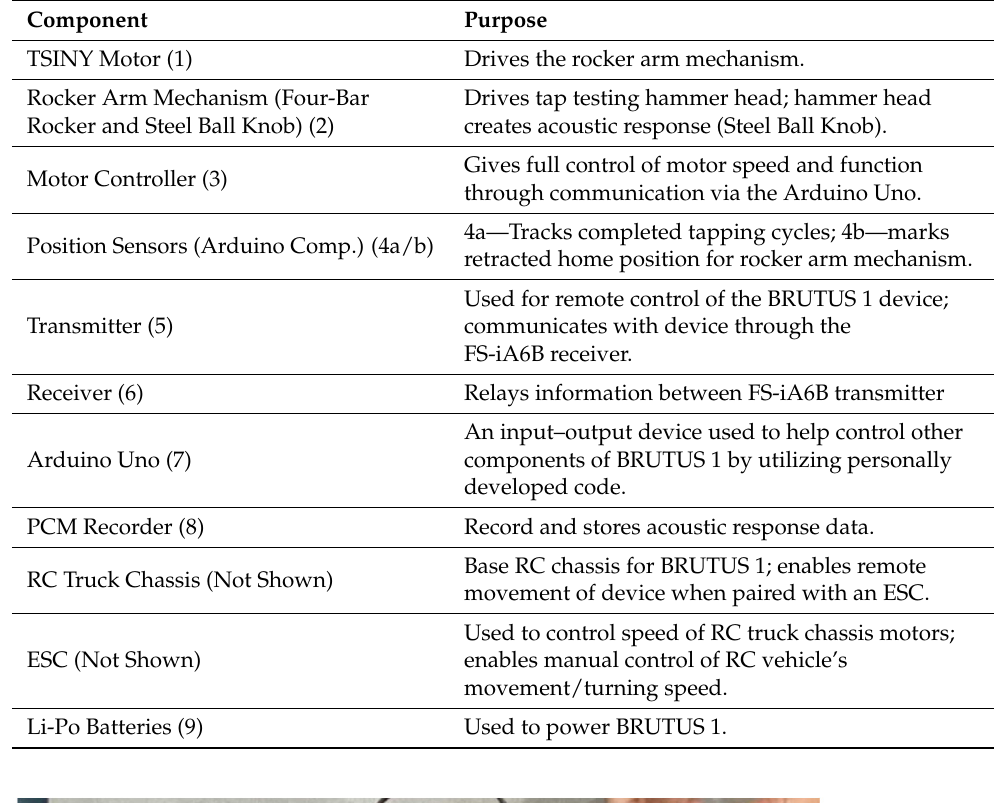
Table 1. Major components of BRUTUS 1.